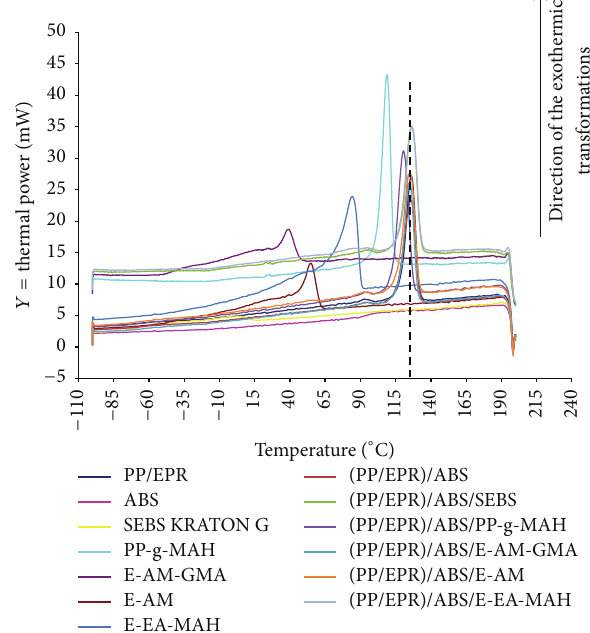
Figure 11: DSC curves in the direction of the exothermic transfor- mations of components and mixtures (PP/EPR)/ABS/compatibiliz- er (95)/5/5, for the first thermal cycle. For about 15mg of sample. 1 graduation 𝑌 = 5 mW.